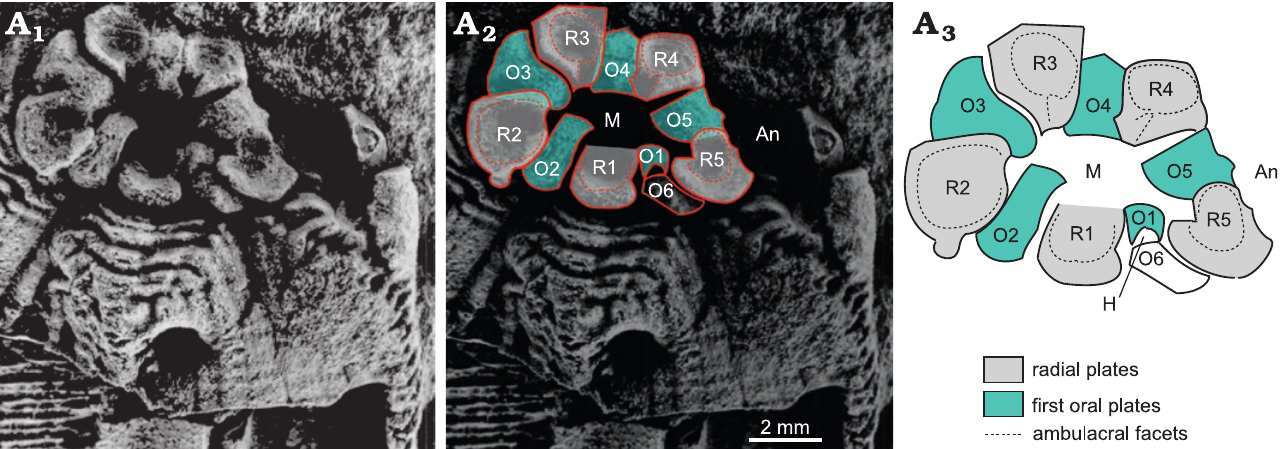
Fig. 19. Oral area of the rhombiferid Rhombifera bohemica Barrande, 1867, repository unknown, Late Ordovician, Czech Republic, showing interpreta- tion of oral plating. A 1 , latex cast of oral area; A 2 , the same with interpretation of oral plating superimposed; A 3 , interpretation of oral plating. An, position of anus; H, position of supposed hydropore; M, mouth; O1–O6, first oral plates; R1–R5, radial plates, which bear the ambulacral facets. R3 supports facet for ambulacrum A, R4 ambulacrum B, etc. clockwise around the mouth. Early glyptocystitoids had six radials. In the Rhombiferidae Kesling, 1962, there are only five; R6 is missing. Photograph from Kesling 1962: pl. 2, fig. 1,